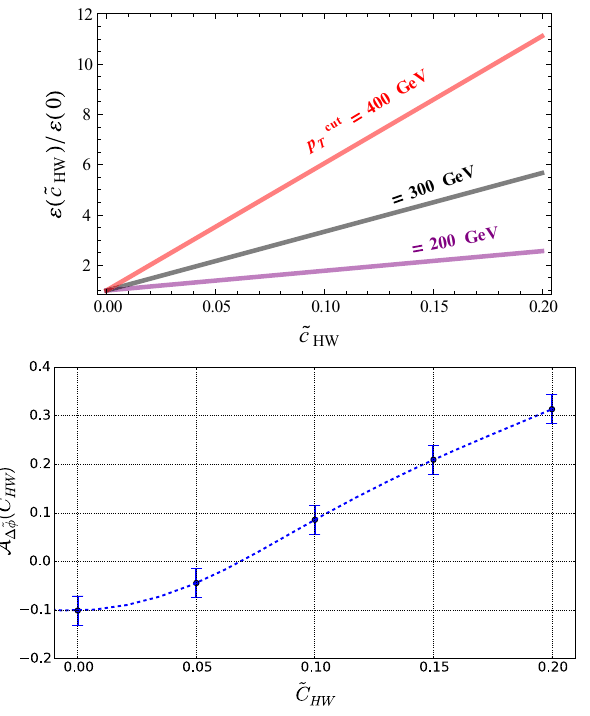
Fig. 11 Representativekinematicalpropertiesofthedecayproductsof a W -boson pair produced in LHC collisions at a center-of-mass energy of 13 TeV. We consider the invariant mass of the dilepton pair issued from the WW system (top) and the ˜ O 1 observable defined by Eq. (32) (bottom). We allow for different values for the ˜ c 3 W parameter and we present, in the lower panels, the bin-by-bin ratio of the new physics predictions to the Standard Model